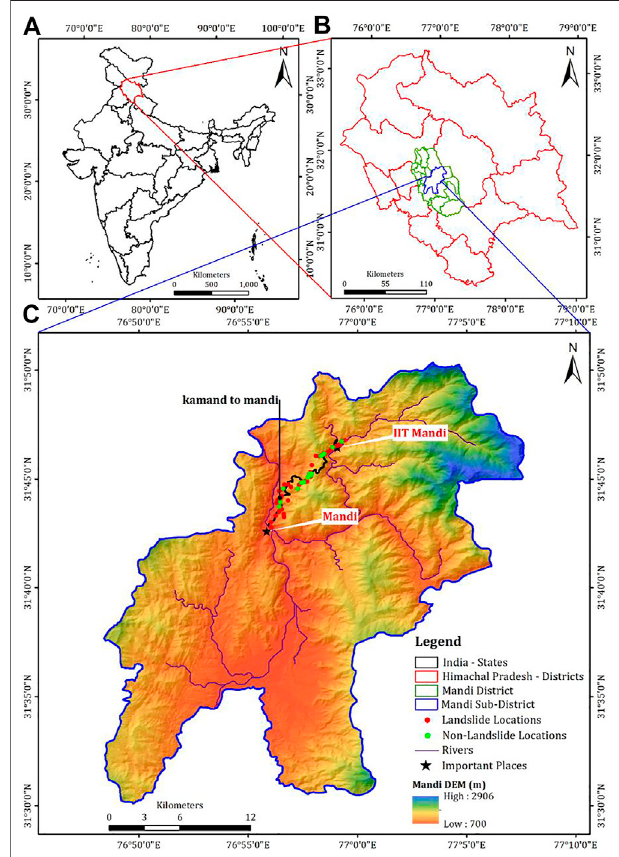
FIGURE 1| Locations ofsites where data were collected for the study in India. (A) Map of India showing Himachal Pradesh state. (B) Map of Himachal Pradesh showing Mandi district. (C) The sites in Mandi district where soil samples were collected. Red dots show the soil samples were collected from the landslide locations, and green dots show the soil samples were collected from the no-landslides locations.